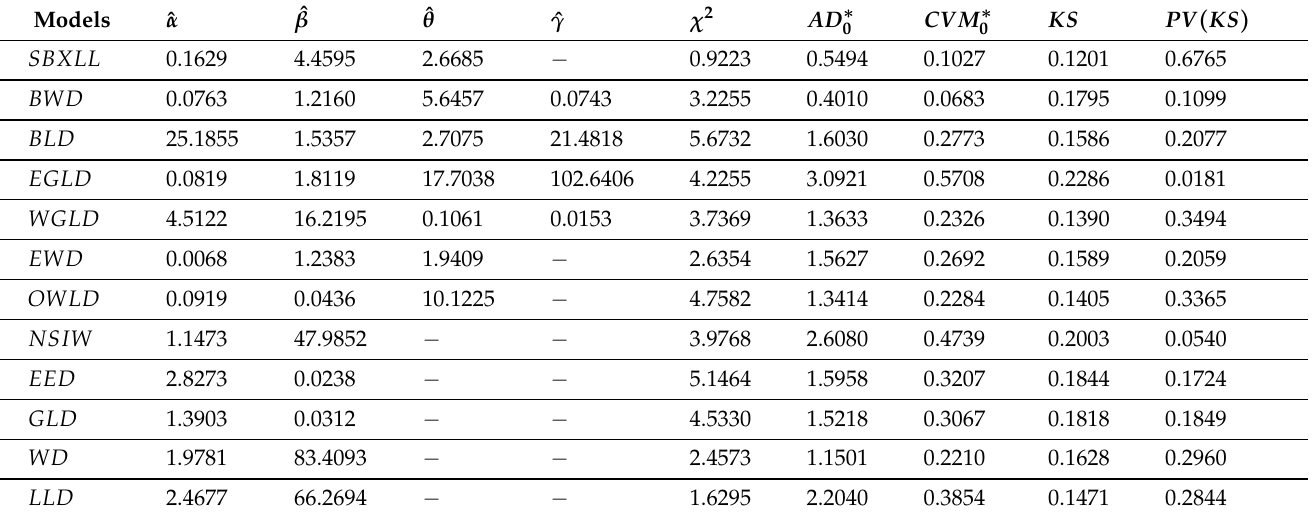
Table 22. MLEs and goodness-of-fit related to data set-IV.